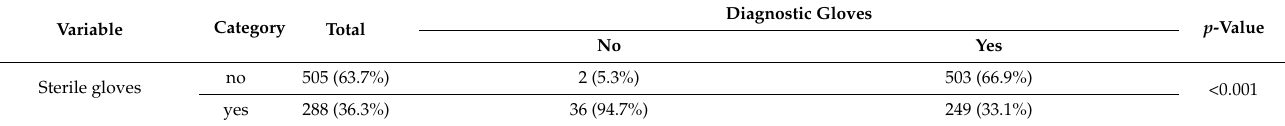
Table 5. Procedures, sharp equipment, and source of knowledge: safety procedures